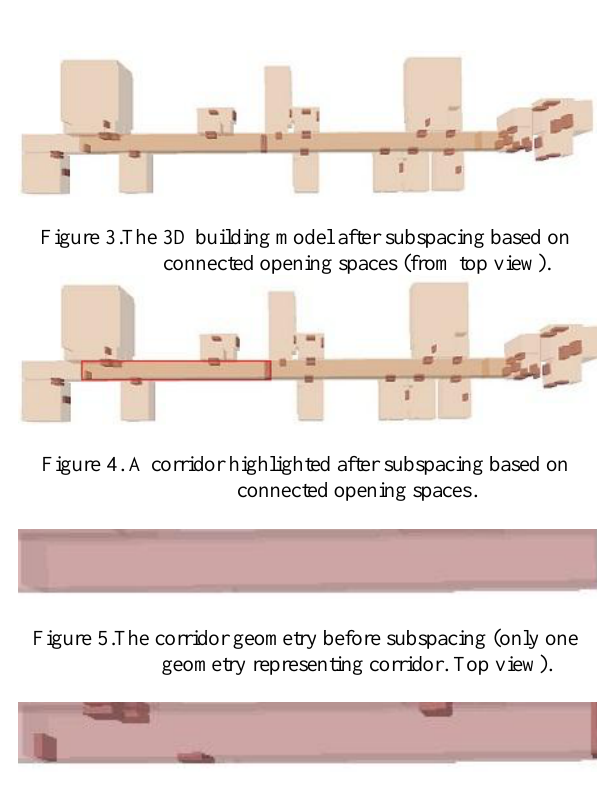
Figure 6.The corridor geometries after subspacing (7 geometries representing corridor. Top view).